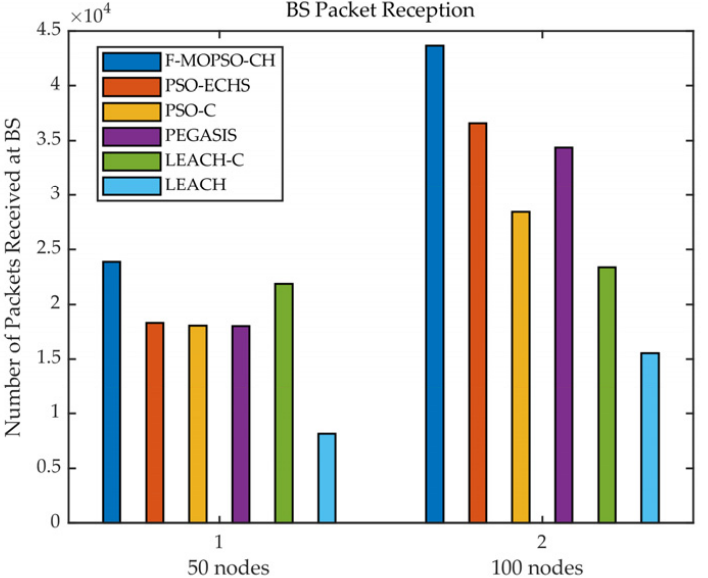
Figure 11. Comparison of BS packet reception. The F-MOPSO-CH was compared with PSO-ECHS, PSO-C, PEGASIS, LEACH-C, and LEACH. The first node death (FND) and the 50% node death (HND) are presented in Figure